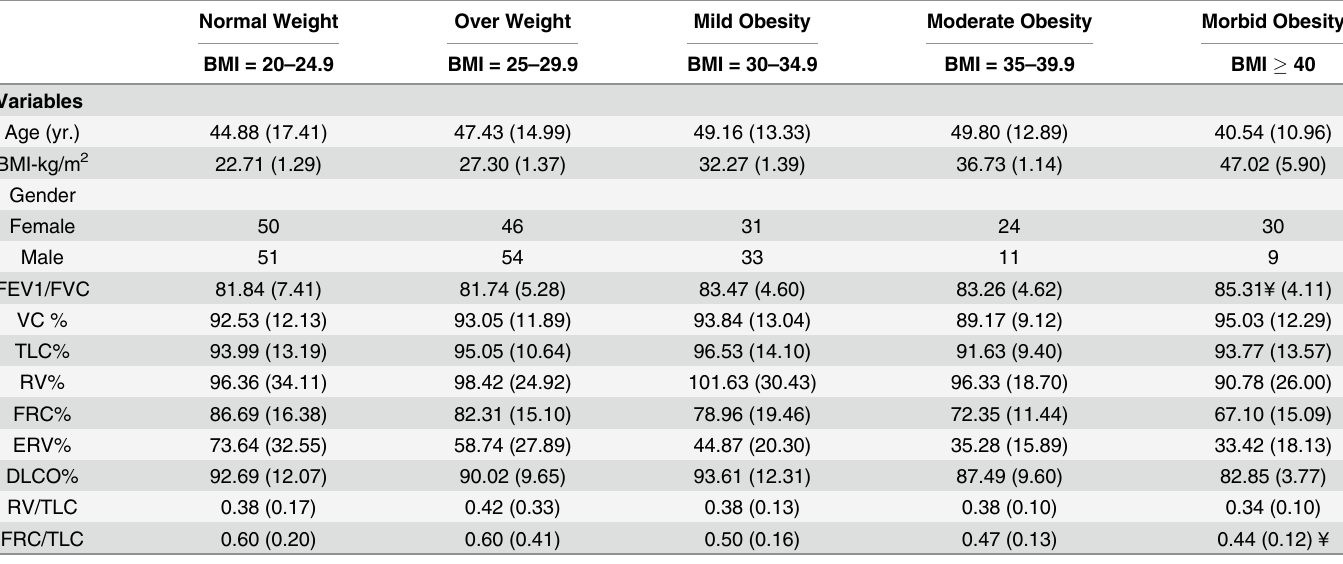
Table 1. Demographics and Pulmonary Function Results for the Different BMI Groups (Kg/m 2 ). Normal